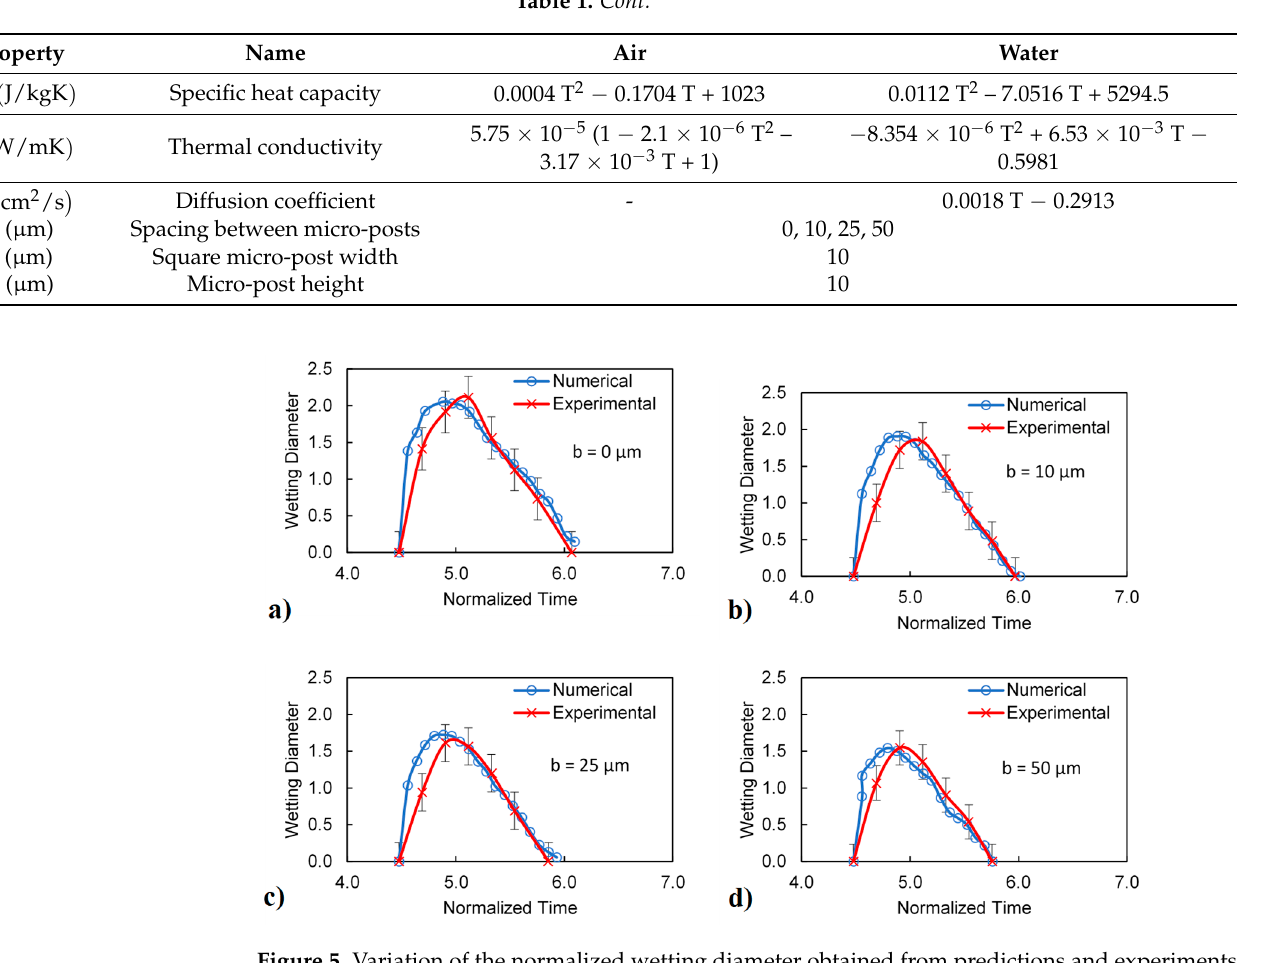
Figure 5. Variation of the normalized wetting diameter obtained from predictions and experiments during spreading and retraction stages for various micro-post spacings: ( a ) hydrophobized flat surface b = 0 µ m, ( b ) b = 10 µ m, ( c ) b = 25 µ m, ( d ) b = 50 µ m. Droplet volume is 10 µ L and impact height is 20 mm.